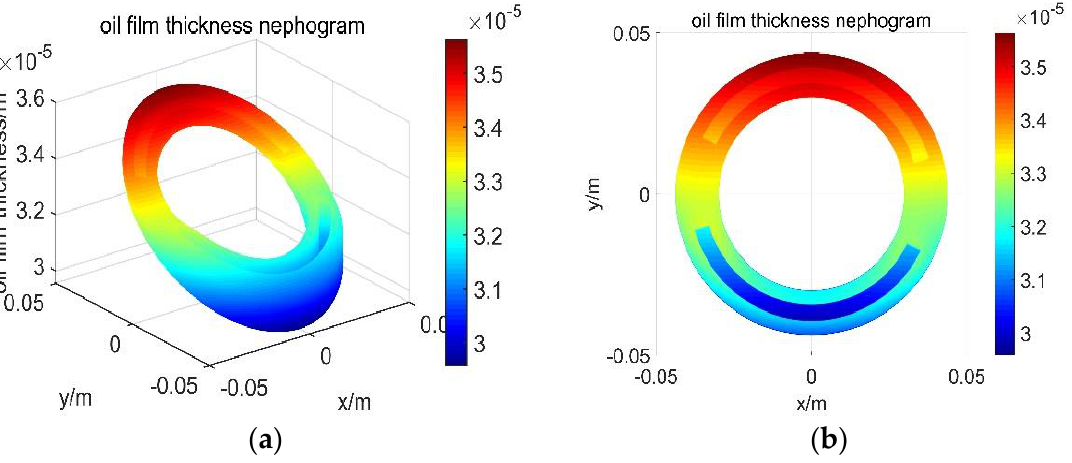
Figure 7. The distribution of the oil film thickness (considered EHL). ( a ) Three-dimensional diagram of EHL distribution; ( b ) top view of the EHL distribution.